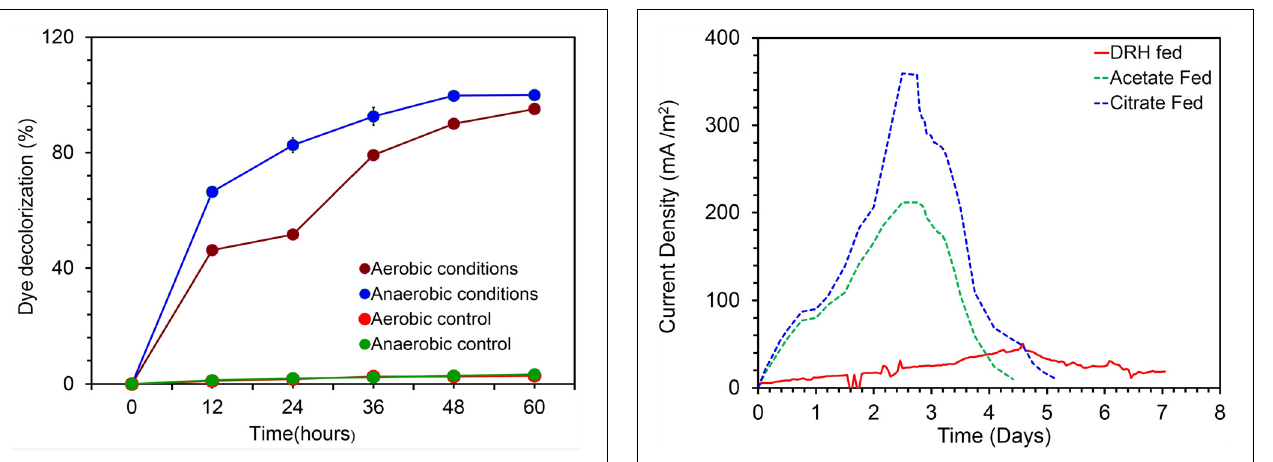
FIGURE 4 | Biodecolourization of diazoic dye RB5 by the strain Citrobacter sp. KVM11 under aerobic and anaerobic environments. Experiments were carried out both aerobically and anaerobically using 20 ml of nutrient broth (Peptone-15g; D (+)glucose-1g;Yeast extract-3g;NaCl-6g) with a concentration of 400 mg l − 1 of an azo dye, Reactive Black5 (RB5). Blue line represents anaerobically grown strain KVM11 cells; Green line shows control samples kept under anaerobic conditions; Maroon line represents aerobically grown strain KVM11 cells; Red line shows control samples kept under aerobic conditions.